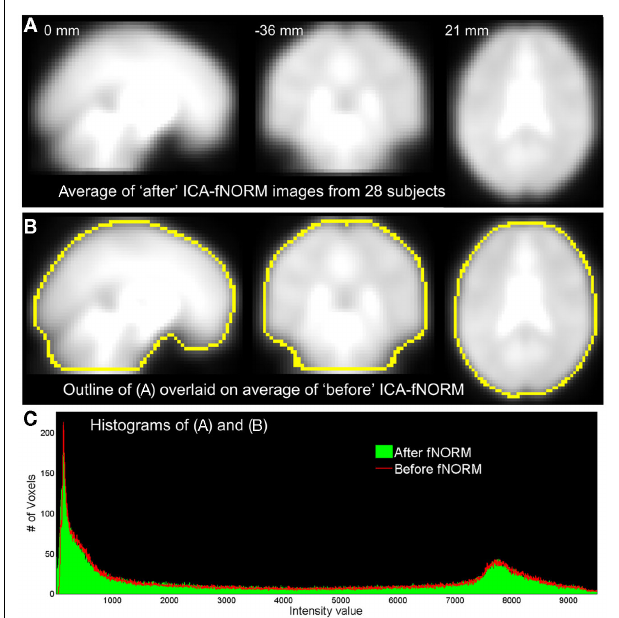
FIGURE 4 |Averaged data from all 28 subjects in three orthogonal views corresponding to the two methods under comparison: (A) after ICA-fNORM; (B) before ICA-fNORM with overlaid boundaries extracted from images in (A); (C) intensity histograms corresponding to images presented in (A,B).